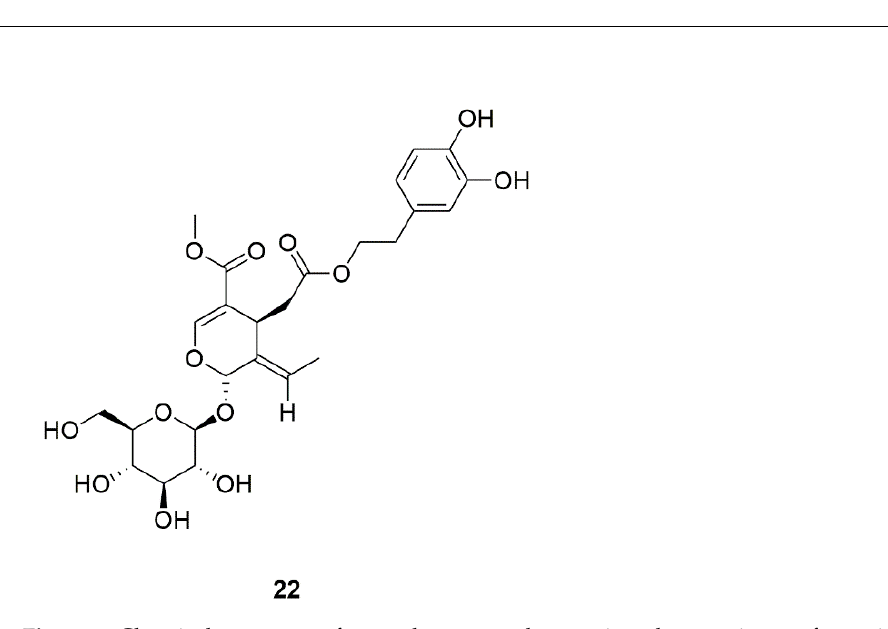
Figure 8. Chemical structures of natural compounds targeting phenotypic transformation.